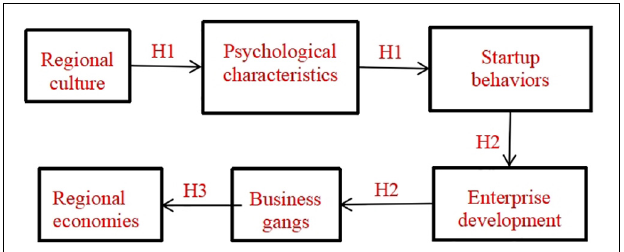
FIGURE 1 | Hypothetical model for the impact of regional cultural differences on modern business